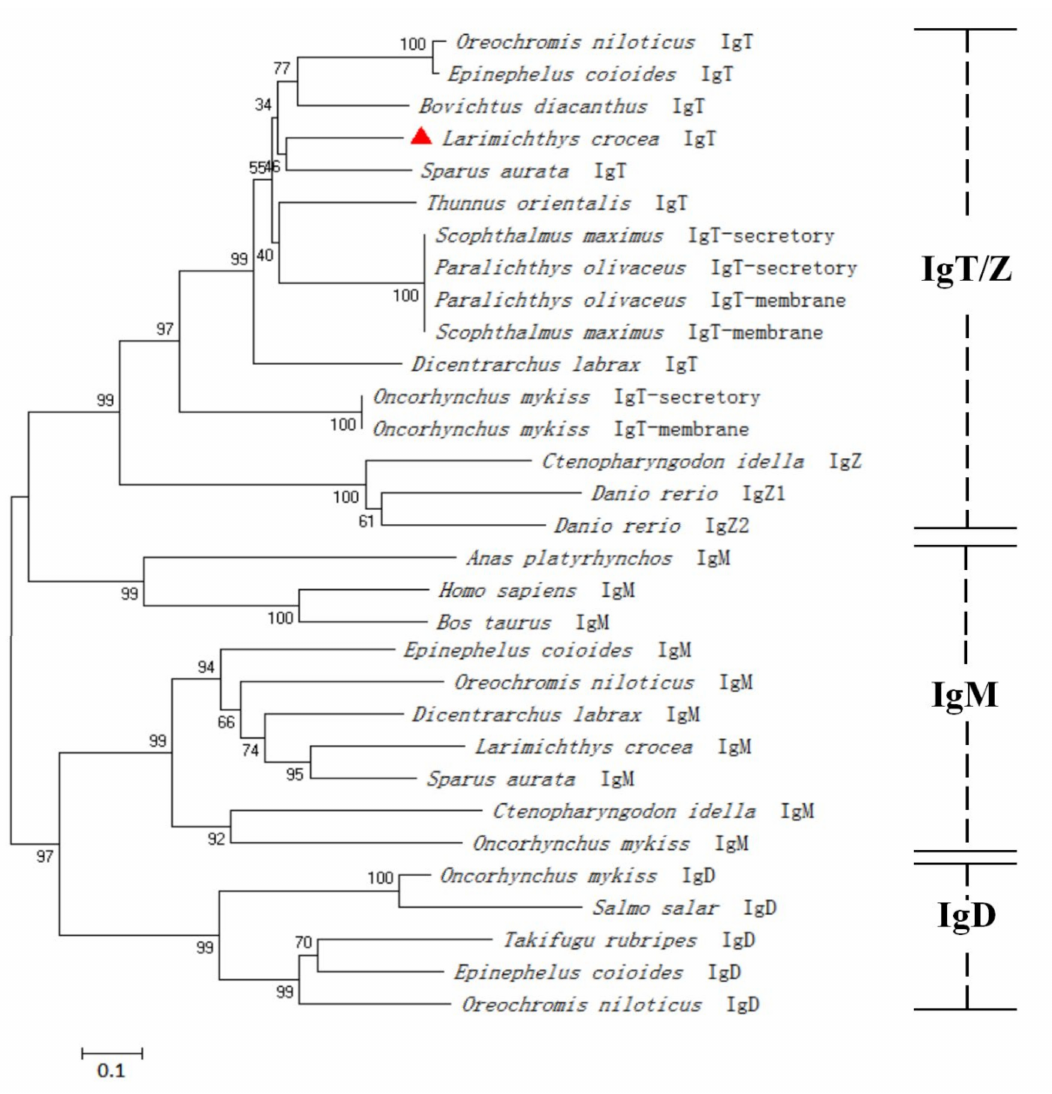
Figure 2. Phylogenetic tree of IgT heavy chain molecules from large yellow croaker and other fish species. A polygenetic tree was constructed to show the genetic relationship between large yellow croaker IgT and other fish species IgT. IgM, IgD heavy chain molecules from fish and vertebrates, were used as an outgroup. The tree was constructed by MEGA software using the Neighbor Joining (NJ) method, and the numbers on nodes represent the frequency with which this node is recovered per 100 bootstrap replications in a total of 1000. Large yellow croaker IgT was marked with a solid red triangle. GenBank accession numbers for IgT heavy chain sequences are as follows: MW450786 Larim- ichthys crocea (large yellow croaker) IgT heavy chain, AKA09828.1 Bovichtus diacanthus (Bovichtus) IgT heavy chain, AUV64181.1 Oreochromis niloticus (Nile tilapia) IgT, ACZ54909.1 Epinephelus coioides (juvenile grouper) IgZ heavy chain, ASK39430.1 Sparus aurata (juvenile seabream) IgT heavy